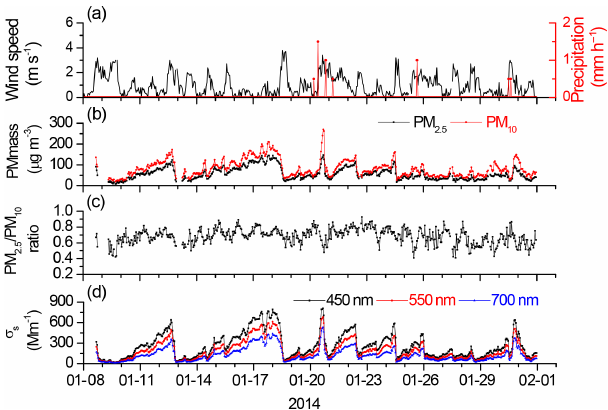
Figure 2. Temporal variations in (a) hourly average wind speed and precipitation, (b) PM 2 . 5 and PM 10 mass concentrations, (c) PM 2 . 5 / PM 10 mass ratio, and light scattering coefficient ( σ s ) at 450, 550, and 700nm at the Daejeon site during January